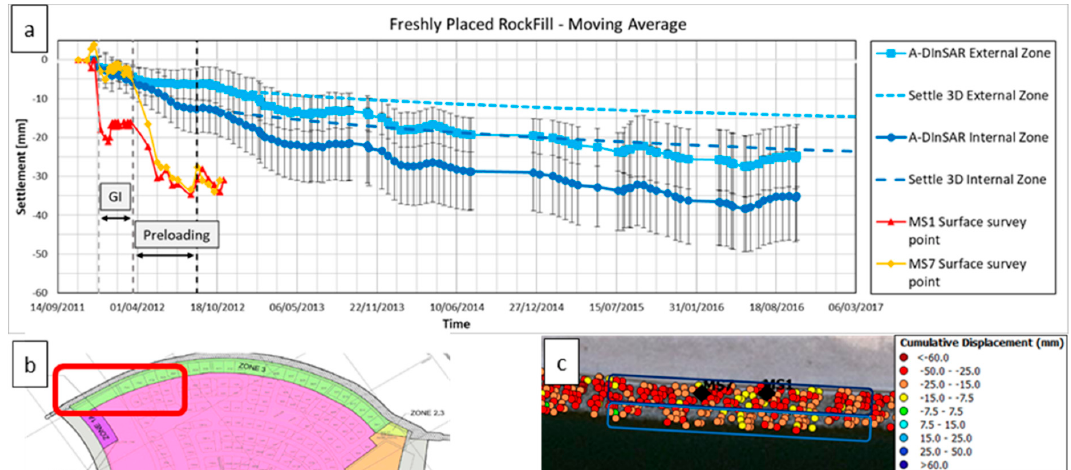
Figure 15. ( a ) Diagram showing the data integration in freshly placed rockfill revetment area including the vertical component of A-DInSAR time series of displacement in dark and light blue, Settle 3D creep in dark and light blue dashed line and field monitoring data in red and yellow. Black and grey dashed vertical lines show the working phases. GI stands for ground improvement. ( b ) Location of the data showed in ( a ). ( c ) A-DInSAR derived MPs (red, orange and yellow dots) and field monitoring data (black dots). Light and dark blue boxes show the external and internal zone, respectively.